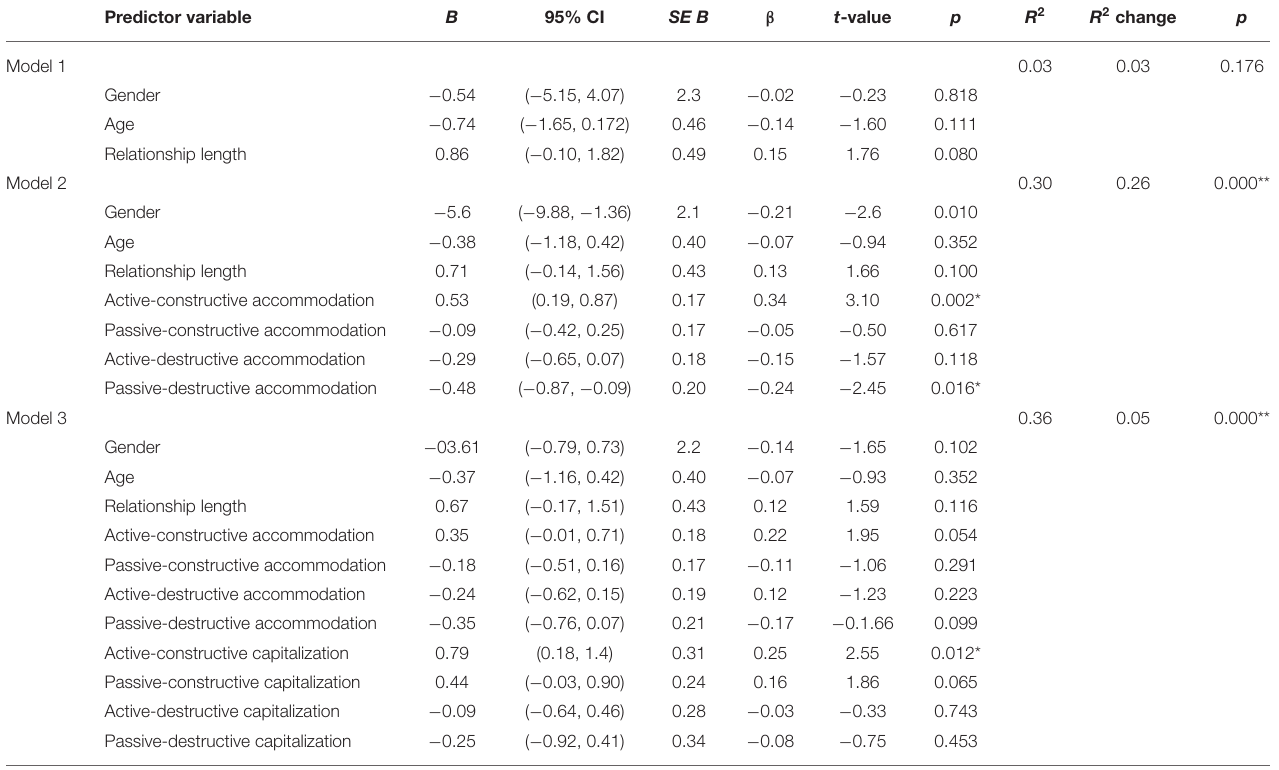
TABLE 6 | Accommodation and capitalization responses as predictors of relationship satisfaction. Predictor